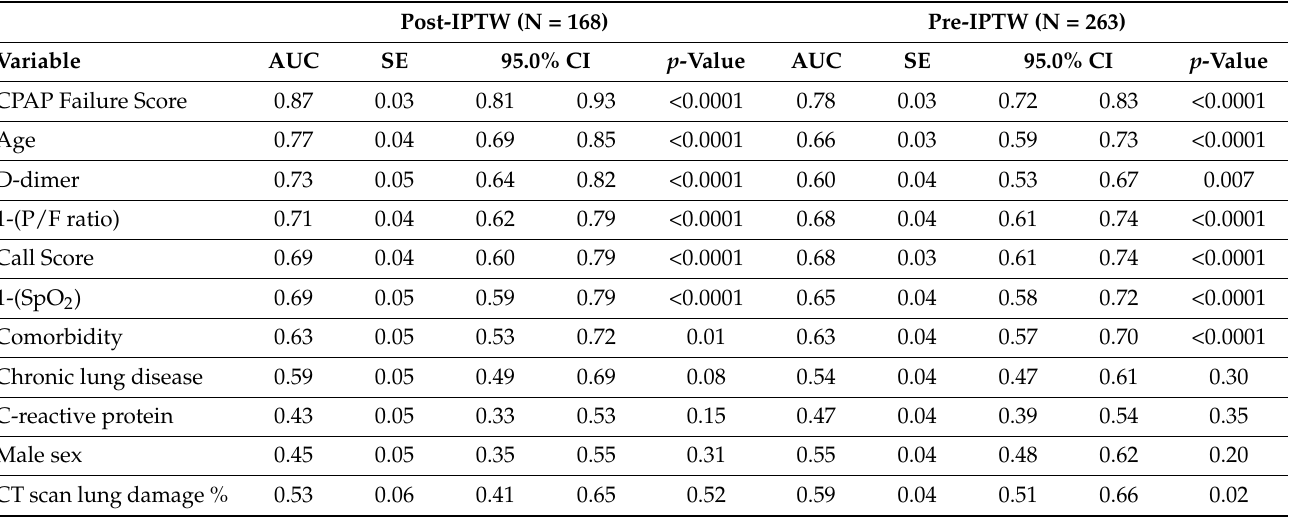
Table 5. Diagnostic ability of the CPAP Failure Score compared to other relevant clinical factors